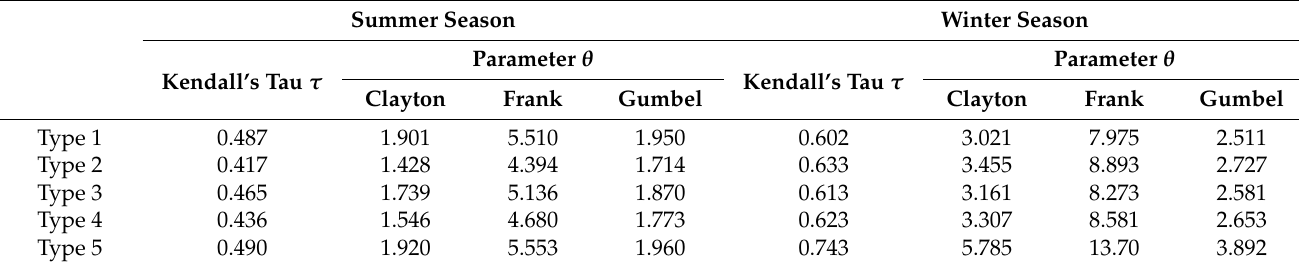
Table 3. Values of τ and θ for the three copulas in summer and winter.